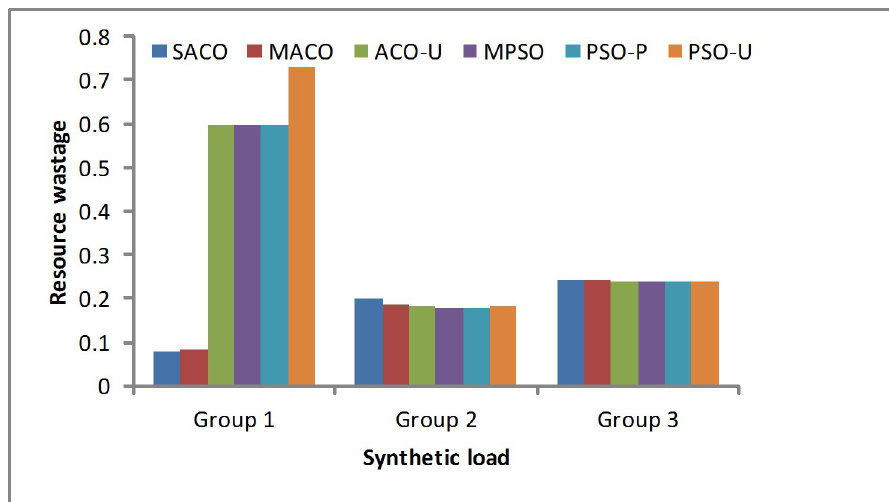
Fig 8. Resource wastage rates in the synthetic